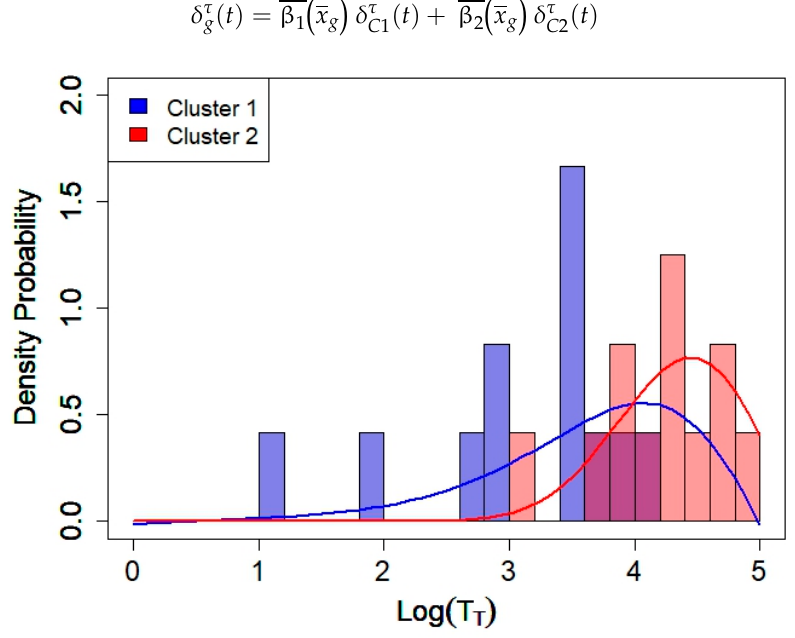
Figure 8. Histograms (from the 24 monitoring stations) and probability distributions, P 1 (x) and P 2 (x), as a function of the non-acoustic parameter, x = Log(T T ), for Clusters 1 and 2. Bin size is 0.2. P 1 (x) and P 2 (x) are the same functions shown in Figure 5.